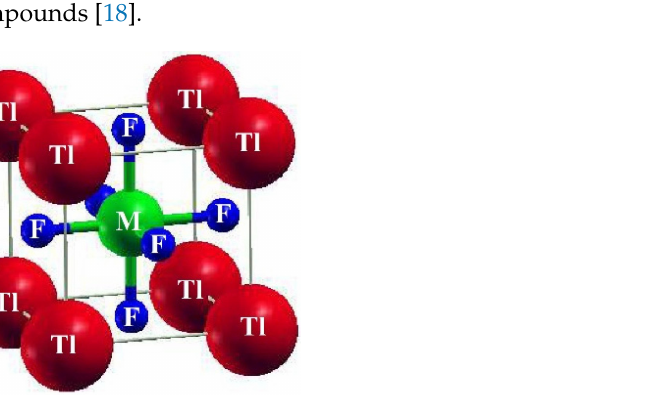
Figure 1. The structure of the basic unit cell of TlMF 3 (M= Au, Ga)